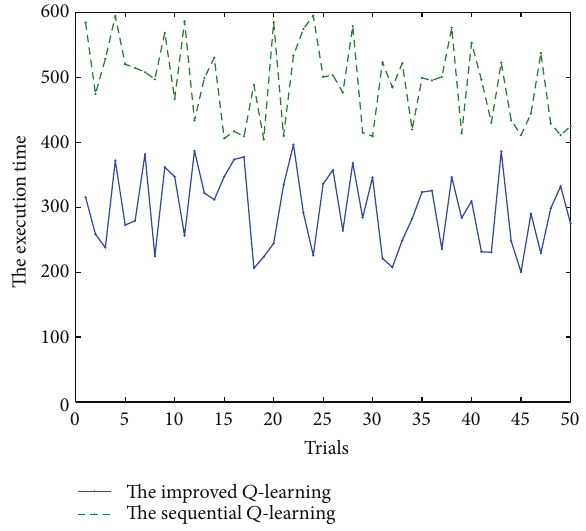
Figure 6: The execution time under different Q -learning algo-